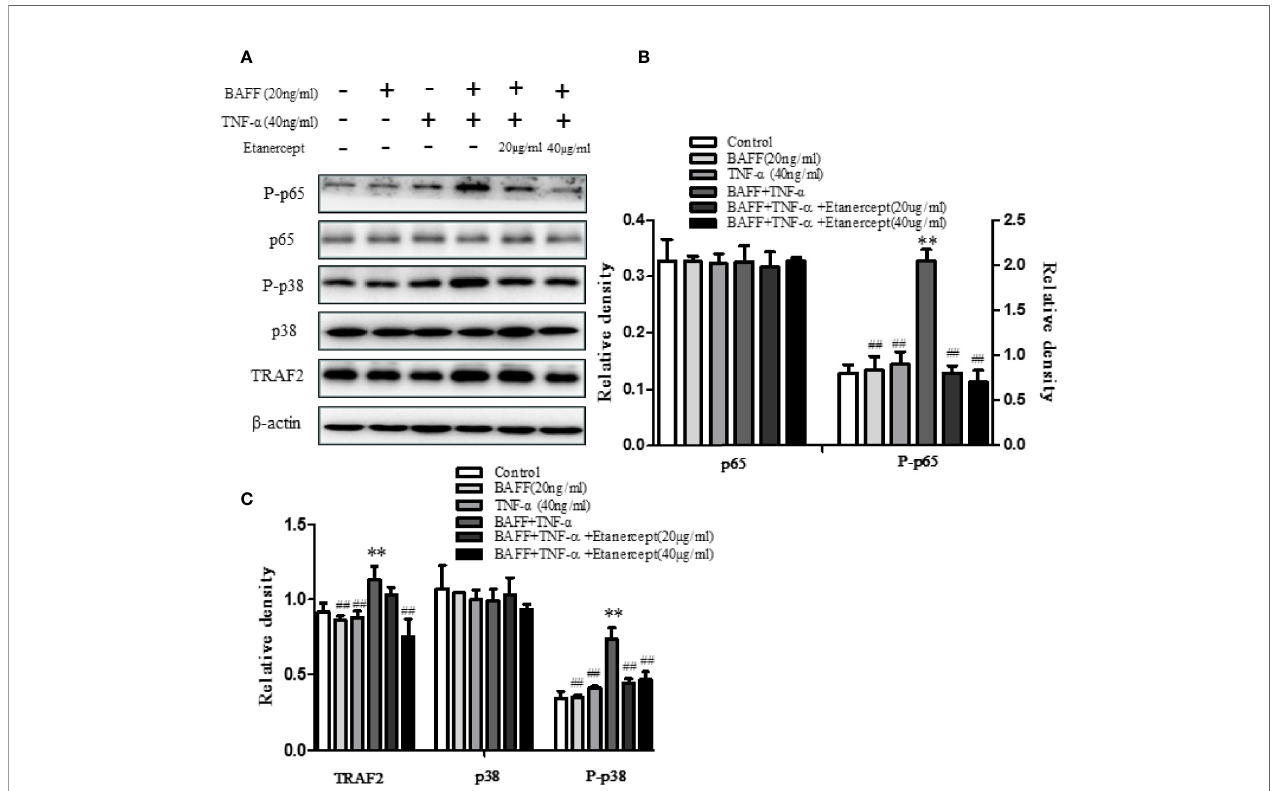
FIGURE 7 | The effect of etanercept on the expressions of TRAF2, p38, P-p38, p65, P-p65 in B cells stimulated by BAFF and TNF- a . (A) The representative graphs of the expressions of TRAF2, p38, P-p38, p65, P-p65 in different groups. (B) The cartogram of the expressions of p65 and P-p65 in different groups. (C) The cartogram of the expressions of TRAF2, p38, and P-p38 in different groups. ** p < 0.01 vs Control group. ## p < 0.05 vs BAFF + TNF- a